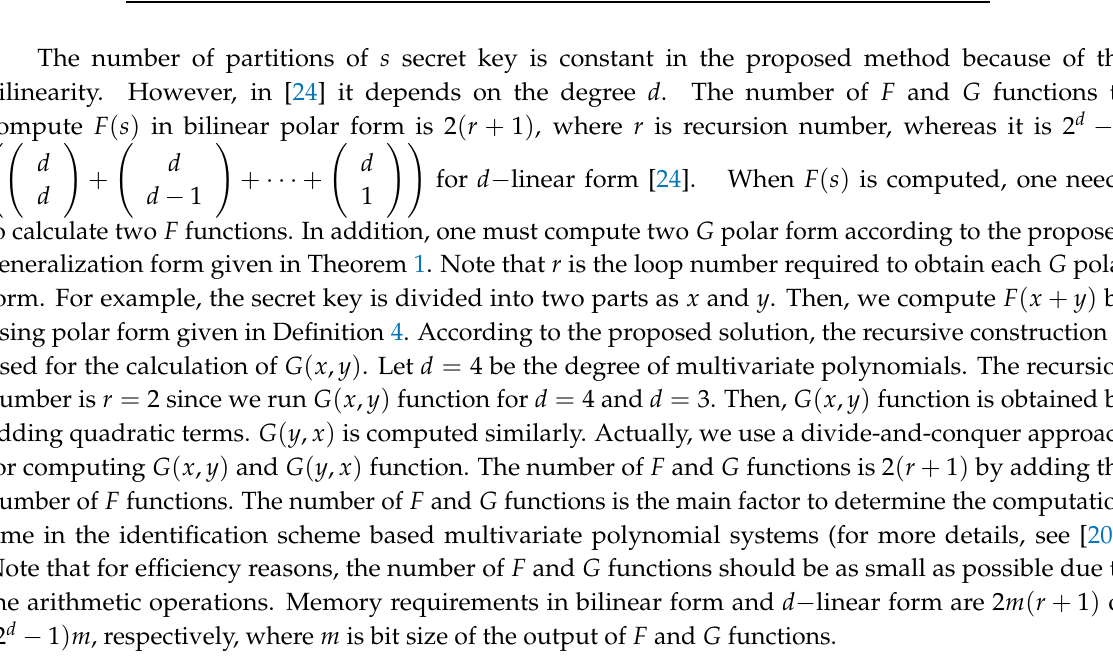
Table 1. Comparison of the proposed solution and d